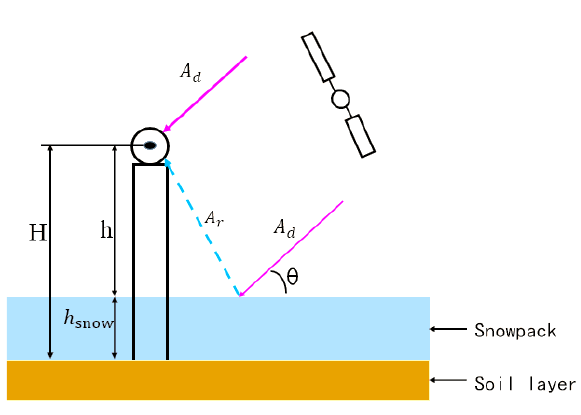
Figure 1. Schematic diagram of GNSS-MR inversion snow